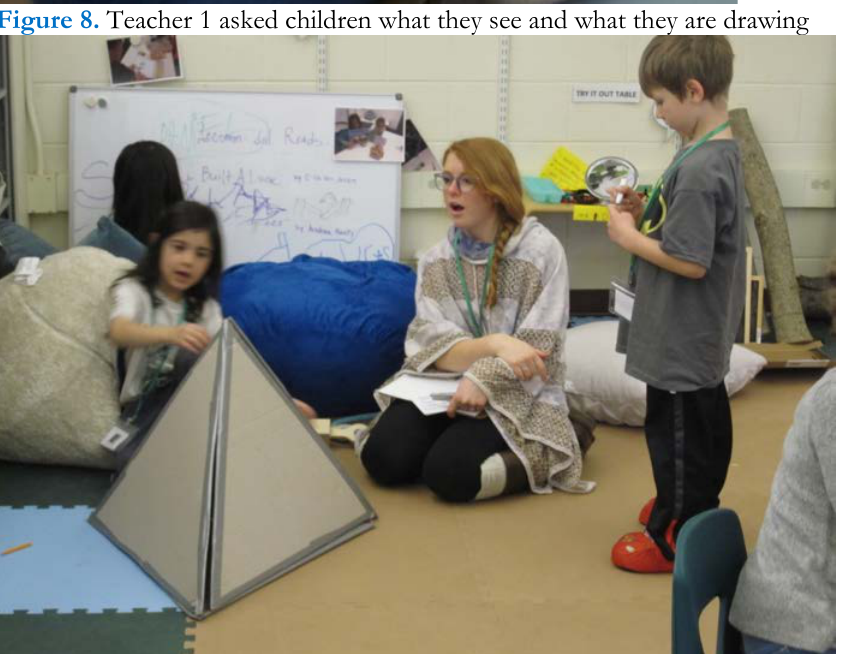
Figure 9. Teacher 2 listened enthusiastically and asked questions while a child explained his building design to